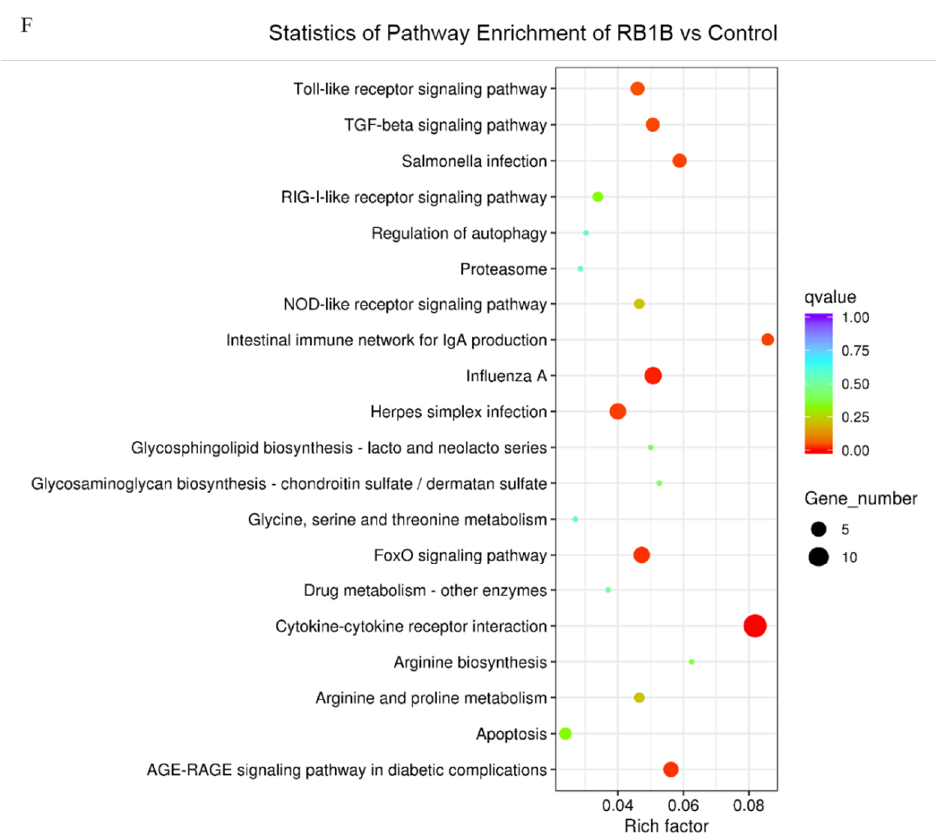
Figure 3. Gene Ontology (GO) terms and KEGG pathway enrichment of the DEGs. The most enriched GO terms for up-regulated DEGs in CVI988 versus control ( A ) and vvRB1B versus control ( B ), down-regulated DEGs in CVI988 versus control ( C ), and vvRB1B versus control ( D ). The most enriched KEGG pathway for up-regulated DEGs in CVI988 versus control ( E ) and vvRB1B versus control ( F ). (* indicates significant enrichment of GO term; q value (range 0–1) is the p value that was corrected by multiple hypothesis tests. The closer the q value is to zero, the more significant the enrichment of the KEGG pathway).